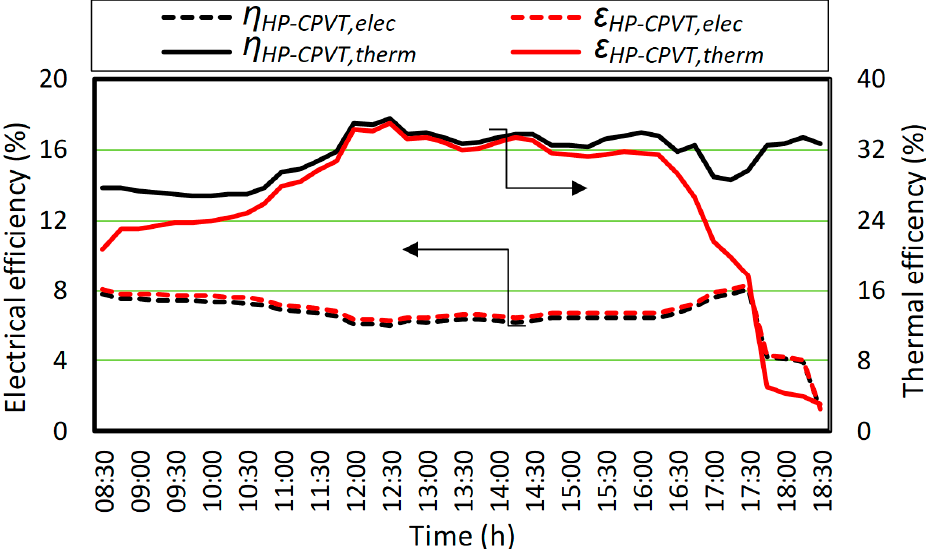
Figure 13. Changes in the electrical and thermal efficiencies of the hybrid HP-CPVT system according to the energy and exergy analyses with Equations (37)–(40).